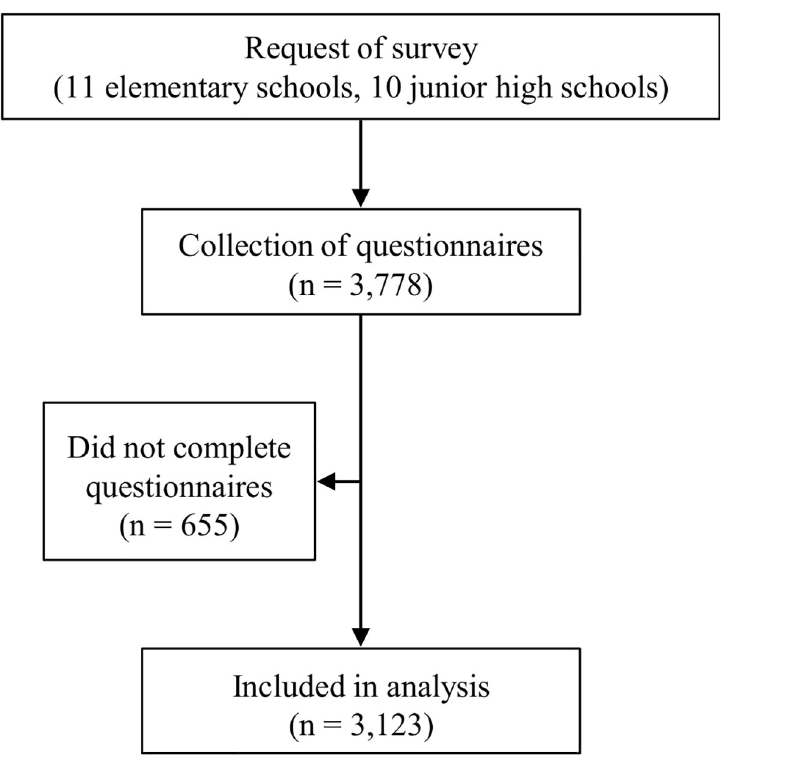
Fig 1. Protocol for research participant